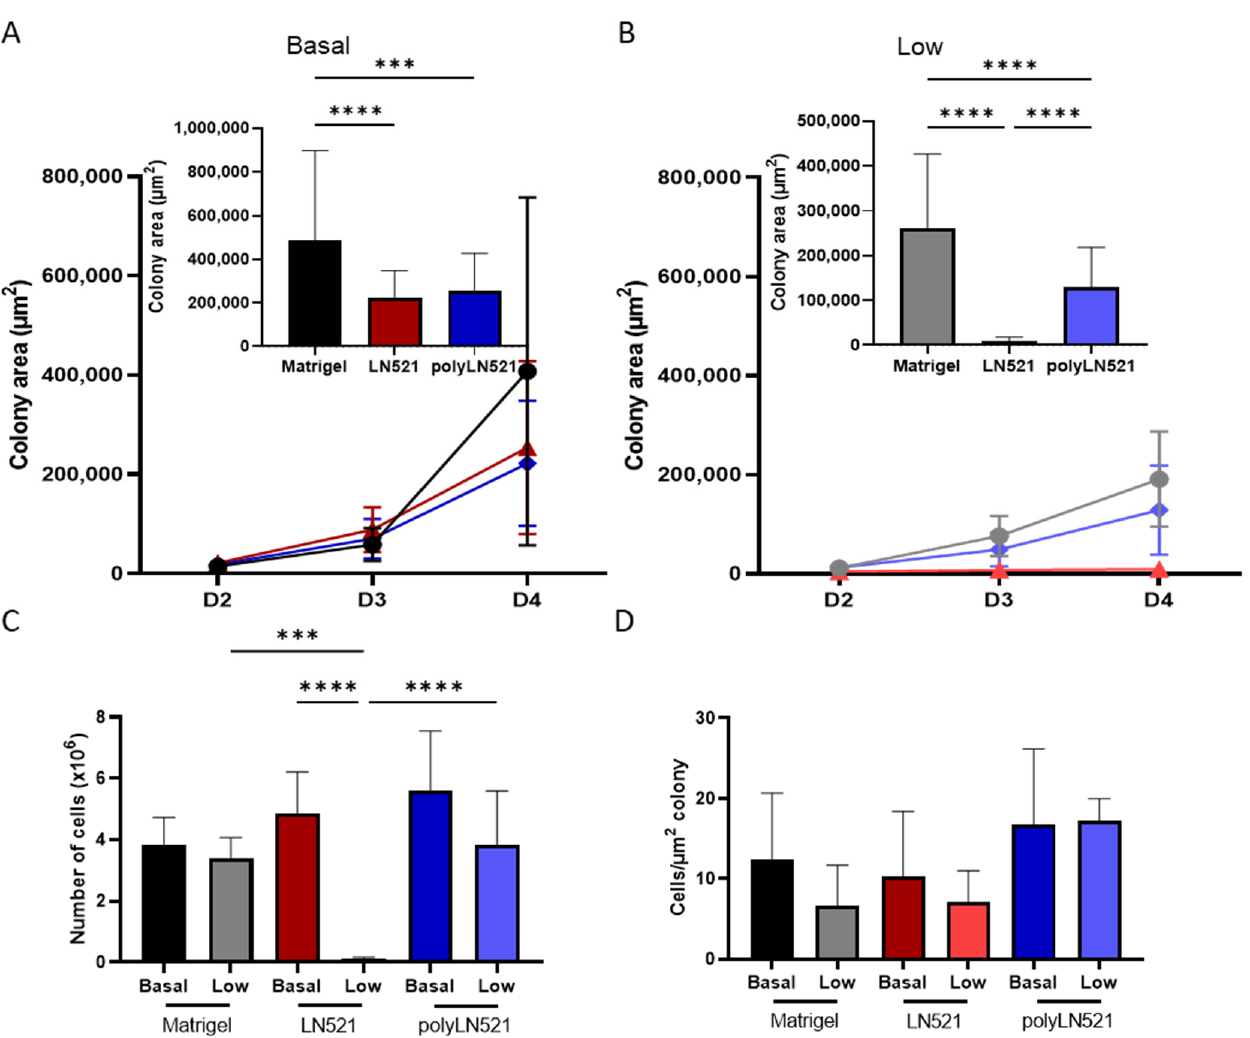
Figure 3. Quantification of expanded human induced pluripotent stem cells (hiPSC). ( A ) Colony area of basal-Matrigel, basal-LN521, and basal-polyLN521 at days 2, 3 and 4 of expansion. Bar graph shows the colony area on day 4 (Matrigel, n = 41; LN521, n = 47; polyLN521, n = 44). ( B ) Colony area of low-Matrigel, low-LN521, and low-polyLN521 at days 2, 3 and 4. Bar graph shows the colony area on day 4 (Matrigel, n = 40; LN521, n = 62; polyLN521, n = 91). ( C ) Number of cells harvested on day 4 (basal- and low-Matrigel, n = 9; basal-LN521, n = 9; low-LN521, n = 7; basal and low-polyLN521, n = 9). ( D ) Ratio of the number of cells to the colony area (basal- and low-Matrigel, n = 9; basal-LN521, n = 9; low-LN521, n = 7; basal- and low-polyLN521, n = 9). *** p < 0.001; **** p < 0.0001. When we compared cell number and colony size on day 4 of expansion among the three coating systems for one of the hiPSC lines (SCVI20), we observed no differences, regardless of basal or low concentration (Figure 3D). In the other hiPSC line (SCVI274), however, we did observe differences in the ratio of cells per µ m2 of colony between low-polyLN521 (23.57 ± 12.81) substrate and basal-Matrigel (5.57 ± 2.33), low-Matrigel (5.61 ± 1.05), and basal-LN521 (5.26 ± 4.04) substrates (Supplementary Figure S1E), al- though we attributed this difference to smaller colony size (132.63 ± 126.68 cm 2 ) and fewer cells counted (2.52 × 10 6 ± 0.80 × 10 6 ). According to the morphologic parameters and proliferation rates, our data suggest that the polymerization of LN521 is crucial to supporting cell survival when using a lower concentration of coating system compared with the gold standard condition